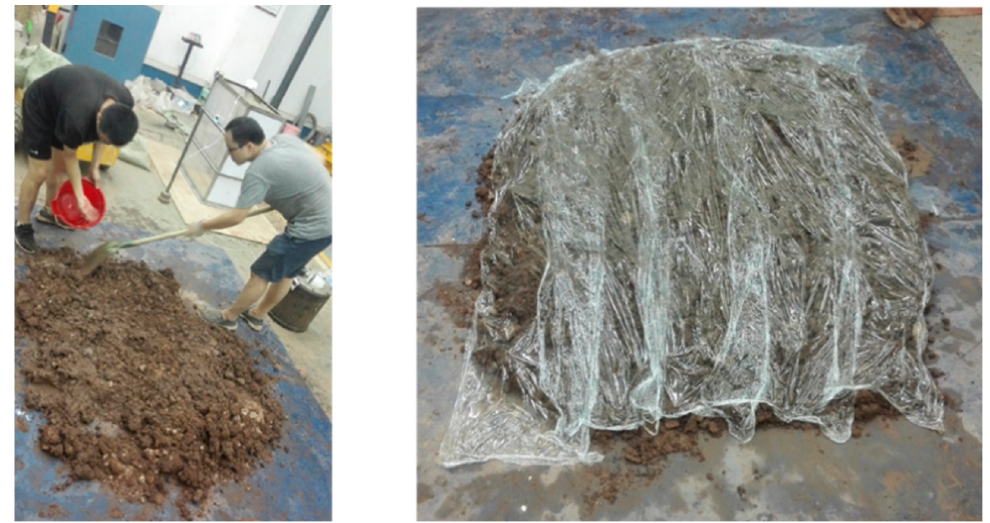
Figure 4. Particle grading test procedure. ( a ) Drying the samples; ( b ) hammering the fine-grained soil; ( c ) sieving the samples; ( d ) separating each particle size and weighing.